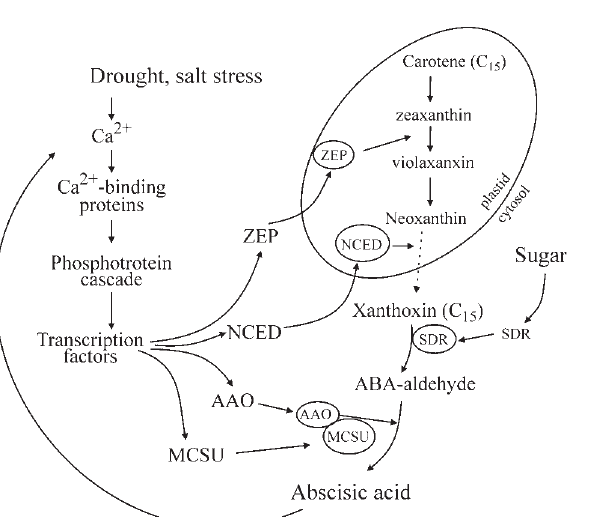
Figure 1 - ABA biosynthesis regulation. The NCED step (indicated by a dashed line) probably limits ABA biosynthesis in leaves. ZEP, zeaxanthin epoxidase; NCED, 9- cis epoxycarotenoid dioxygenase; AAO, ABA-al- dehydeoxidase;MCSU,MoCosulfurase;SDR,short-chainalcoholdehy- drogenase/reductase. Adapted from Xiong and Zhu (2003).